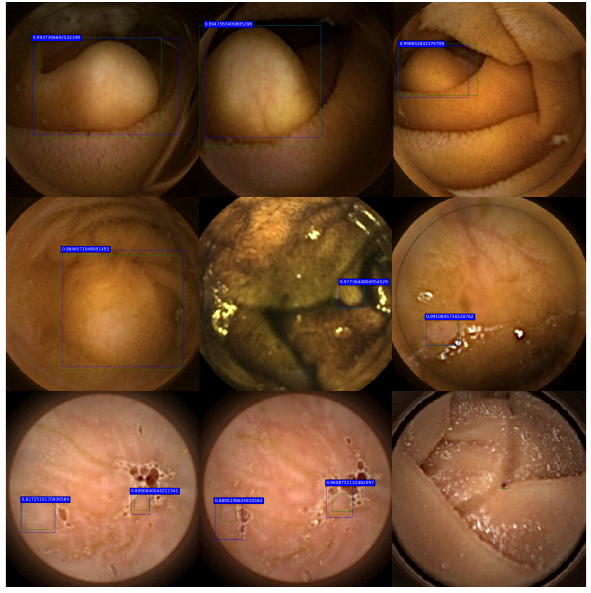
Figure 4. The results of the detection method we proposed. The blue boxes with confidence are our results and the green ones are true